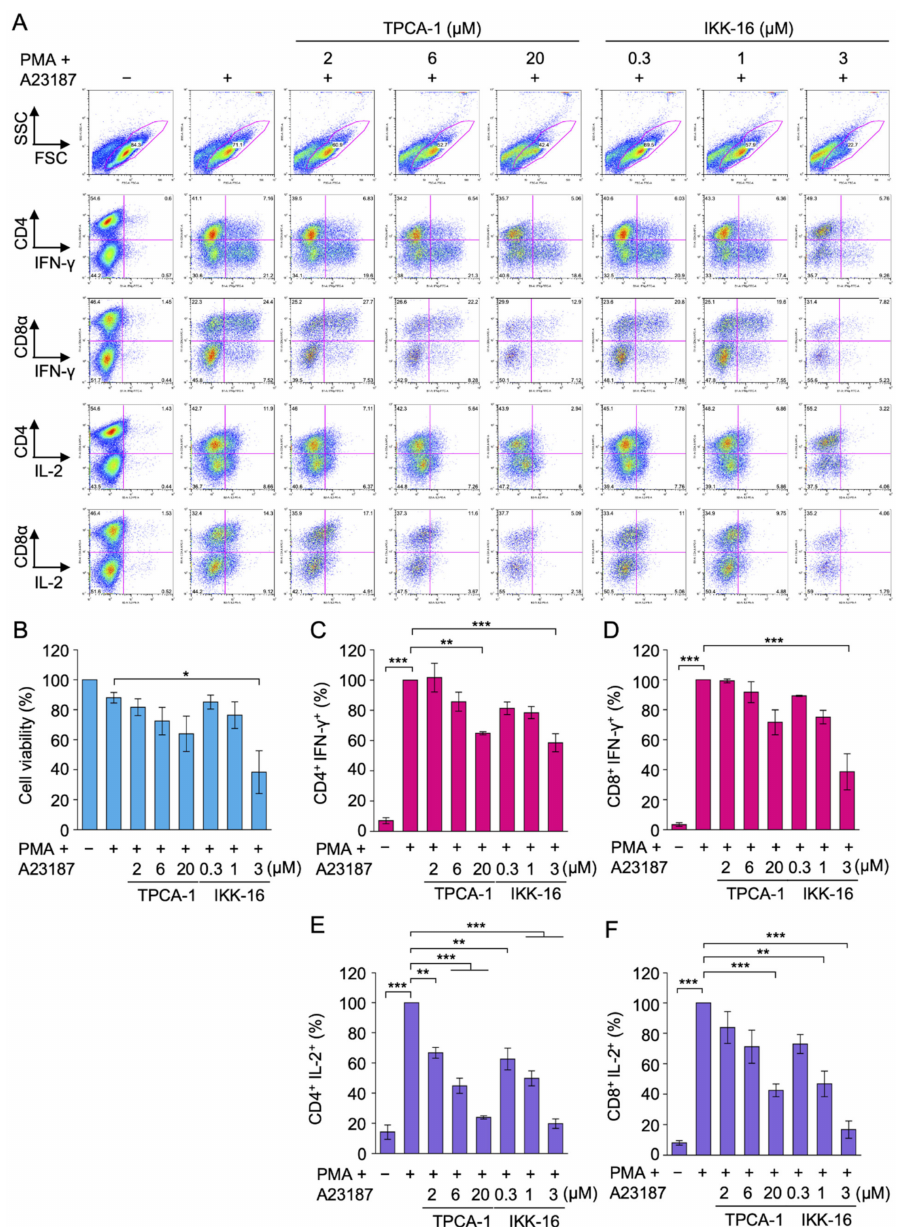
Figure 6. Effects of TPCA-1 and IKK-16 on IFN- γ and IL-2 expression in primary effector T